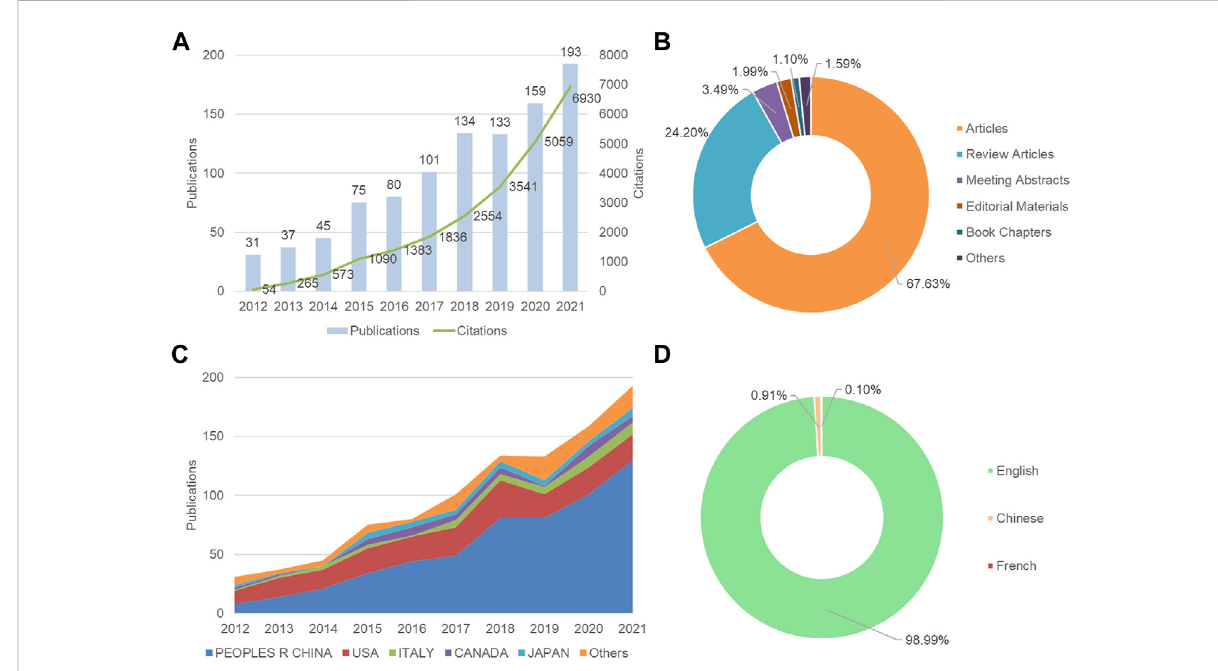
FIGURE 1 Overviewofautophagyinatherosclerosisstudiesfrom2012to2021. (A) Theannualdistributionofpublicationsandcitations; (B) Typeofarticle; (C) The trend of publications of the fi ve most productive countries/regions per year; (D) Language of